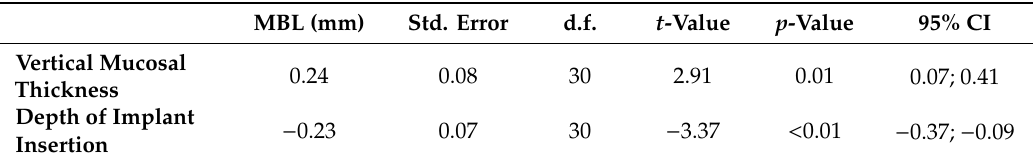
Table 3. Multivariable linear mixed models, analyzing factors influencing marginal bone loss from implant insertion to 12-months after prosthetic loading.